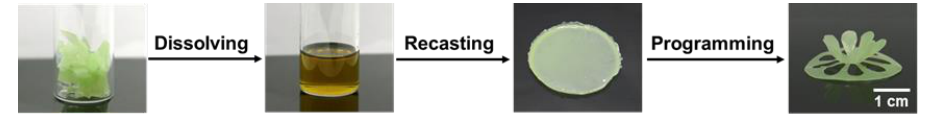
Figure 11. The recasting and reprogramming of the used sample.